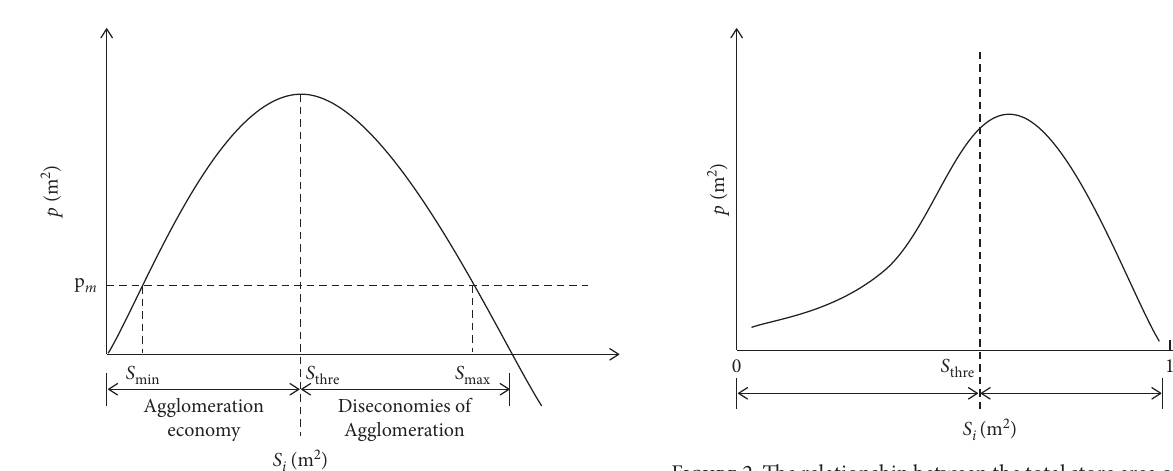
Figure 2: The relationship between the total store area of type i and the total sales of one store of this S i and i .